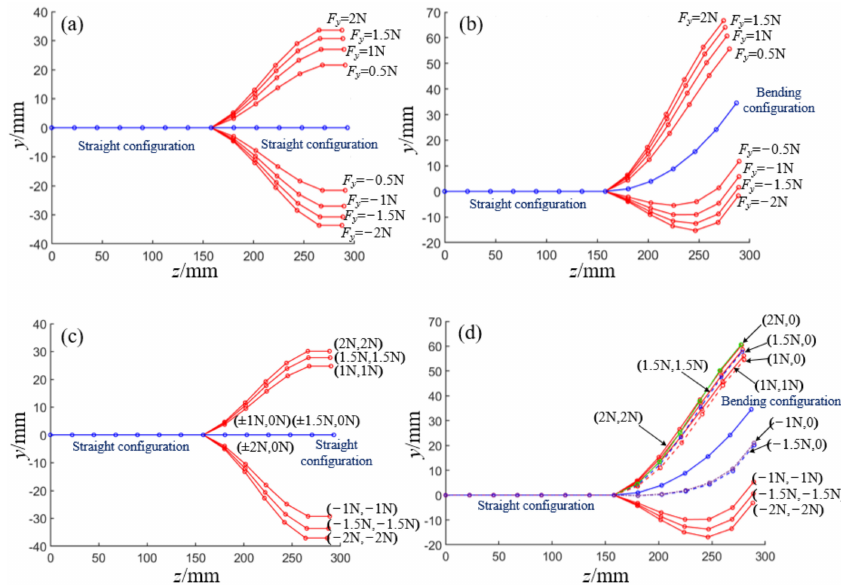
Figure 14. The equilibrium conformations of the distal segment under different external forces. ( a ) The equilibrium conformations of the initial distal segment under different y -direction forces. ( b ) The equilibrium conformations of the bending distal segment under different y -direction forces. ( c ) The equilibrium conformations of the initial distal segment under different two-directions forces. ( d ) The equilibrium conformations of the bending distal segment under different two-direction